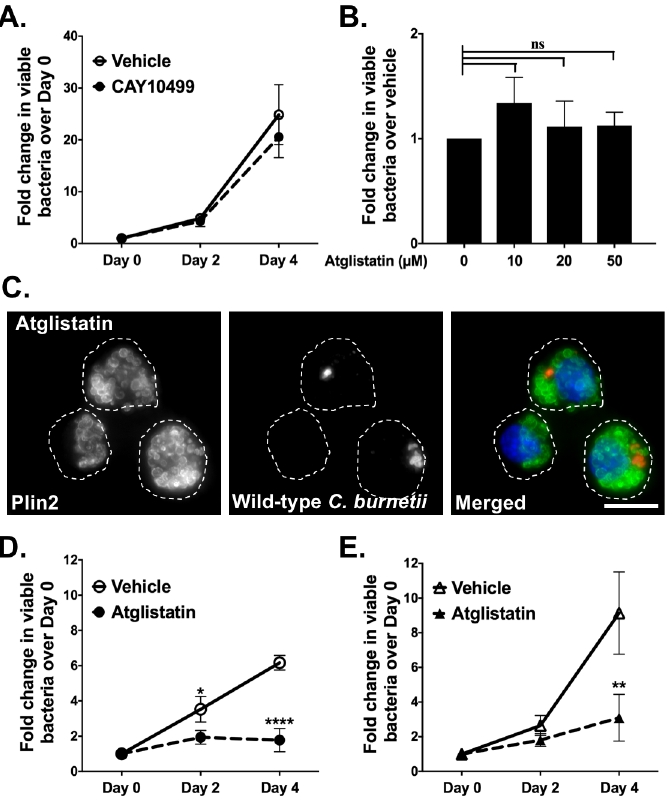
Fig 4. Inhibiting LD breakdown blocks C . burnetii growth. Effect of HSL inhibitor CAY10499 and ATGL inhibitor atglistatin on viability of axenic and intracellular wild-type C . burnetii was determined by FFU assay. A) C . burnetii growth in CAY10499-treated (10 µ M) and vehicle-treated wild-type MH-S macrophages. Error bars represent the mean of 3 independent experiments +/- SEM. ns = not significant compared to vehicle-treated cells as determined by two-way ANOVA with Bonferroni post-hoc test. B) Direct effect of atglistatin on wild-type C . burnetii . Atglistatin was added to axenic C . burnetii cultures and bacterial viability was determined at day 4 using FFU assay. Error bars represent the mean of 3 independent experiments +/- SEM. ns = not significant compared to vehicle treatment as determined by ordinary one -way ANOVA with Tukey post-hoc test. C) Representative image for wild-type MH-S macrophages treated with atglistatin, fixed, stained for PLIN2 (LDs; green) and C . burnetii (red) and imaged day 4 post-treatment at 100X. Scale bar = 10 µ m. D) C . burnetii growth in atglistatin-treated (20 µ M) and vehicle-treated wild-type MH-S macrophages. Error bars represent the mean of 4 independent experiments +/- SEM. (cid:3) = p < 0.05, (cid:3)(cid:3)(cid:3)(cid:3) = p < 0.0001 compared to vehicle-treated cells as determined by two-way ANOVA with Bonferroni post-hoc test. E) C . burnetii growth in atglistatin-treated (20 µ M) and vehicle-treated acat-1 -/- MH-S macrophages. Error bars represent the mean of 4 independent experiments +/- SEM. (cid:3)(cid:3) = p < 0.01 compared to vehicle-treated cells as determined by two-way ANOVA with Bonferroni post-hoc